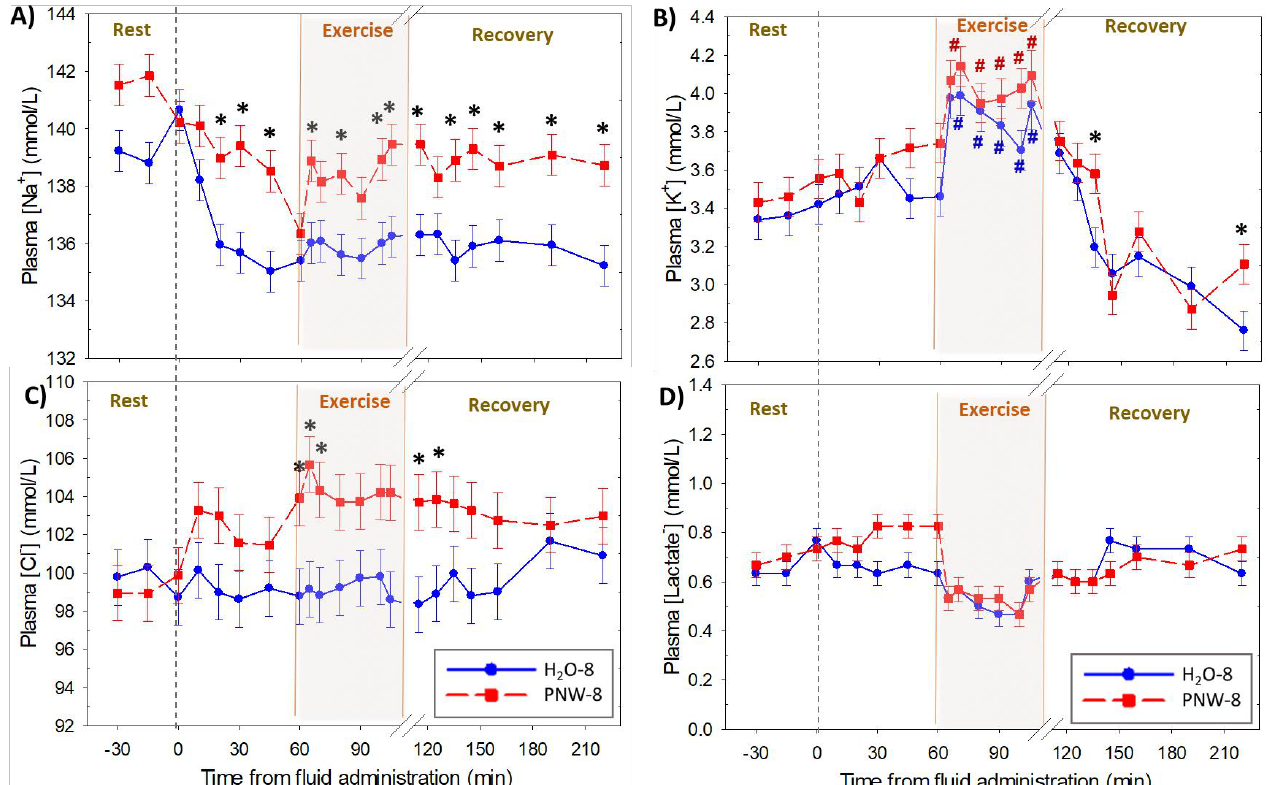
Figure 5. Time course of plasma strong ion concentrations at rest, during moderate intensity exercise and up to 2 h of recovery. Data are mean + SEM for plasma concentrations of ( A ) sodium (Na + ), ( B ) potassium (K + ), ( C ) chloride (Cl − ) and ( D ) lactate - for n = 4 horses. In a randomized crossover design horses were administered wither 8L of water (control) or a balanced, hypotonic electrolyte solution (PNW-8) 60 min before they exercised on a treadmill at 50% of peak VO2 for 45 min. # and * denote p < 0.05 vs. time 0 and 8L H2O (H2O-8), respectively.